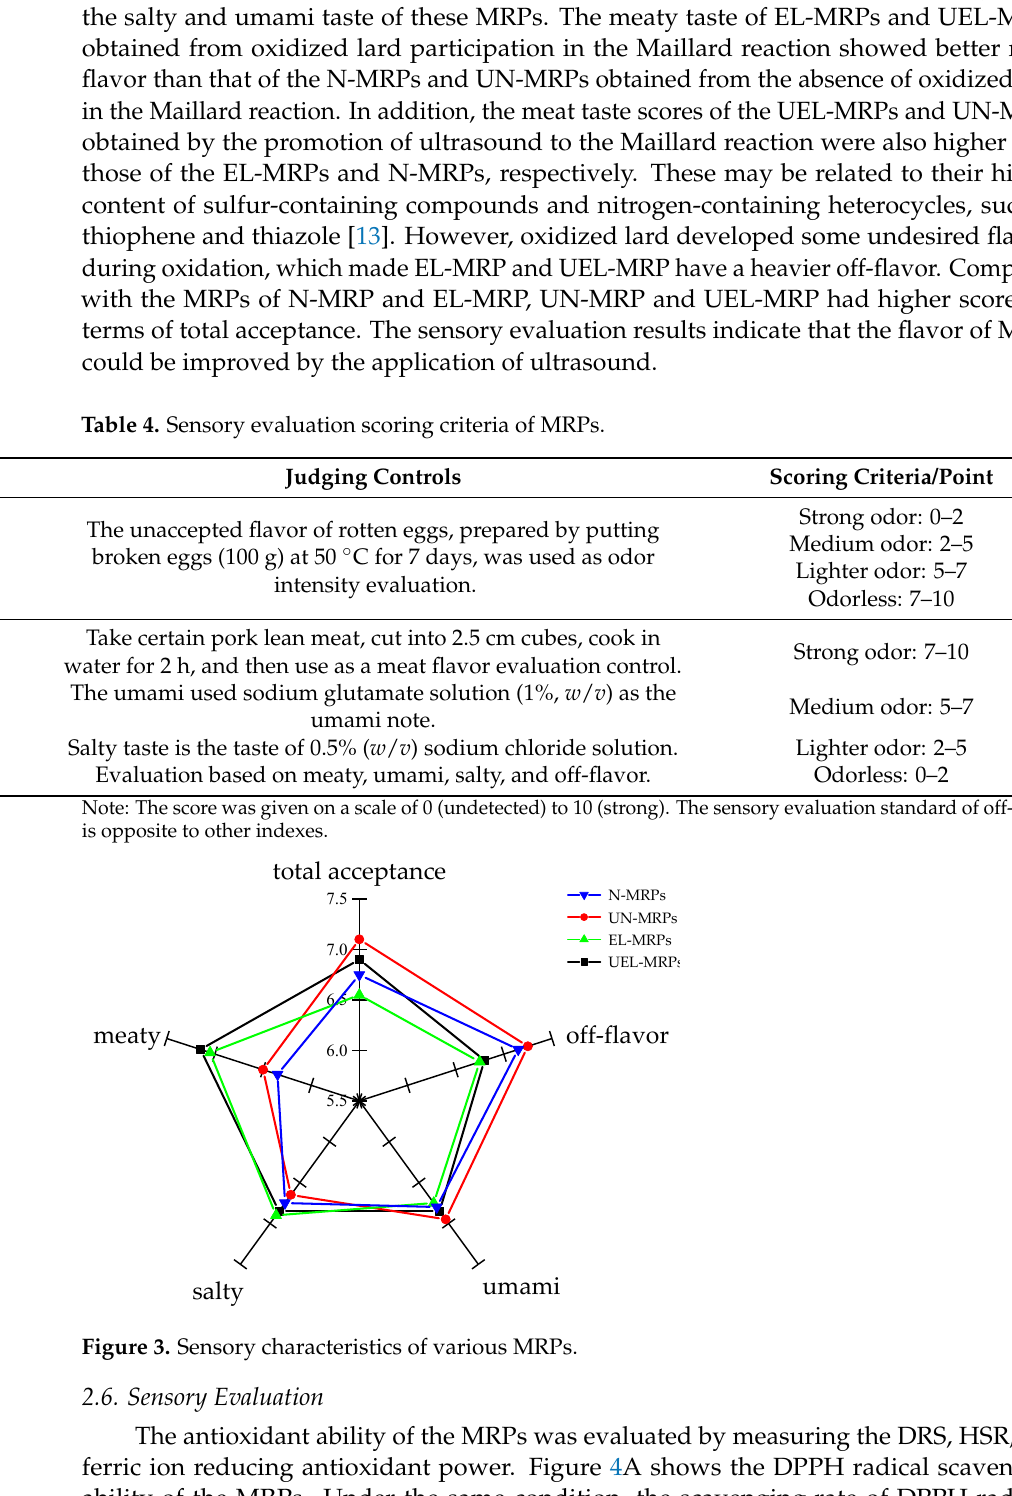
Figure 4. Antioxidant activity of various MRPs. ( A ) DPPH free radical scavenging activity. ( B ) Hy ‐ droxyl radical scavenging ability. ( C ) Reducing power, expressed in absorbance read at 700 nm. According to the antioxidant analysis, we can find that UN ‐ MRPs showed the best antioxidant ability among these MRPs. This may be because the ultrasound ‐ assisted heat treatment accelerates the Maillard reaction, thereby generating more substances with an ‐ tioxidant capacity [1]. It has been reported that the produced intermediate pyrroles and melanoids in the final products of the Maillard reaction have the antioxidant capacity [15,33]. According to the results of the browning intensity measurement and SPME/GC ‐ MS, more intermediate substances, melanoids, and nitrogen ‐ containing heterocycles were found in the UEL ‐ MRPs. However, the antioxidant capacity of UEL ‐ MRP was measured to be the lowest among these MRPs, and that of EL ‐ MRPs was the second lowest. Studies have shown that fragments of 30–50 kDa in the MRPs have high antioxidant activity [34,35]. The possible reason for the difference in the antioxidant activity of the MRPs may be due to the distribution of the molecular weights in these MRPs. Future work will focus 0.1 0.2 0.3 0.4 0.5 0.60.00.20.4 0.60.8 0.2